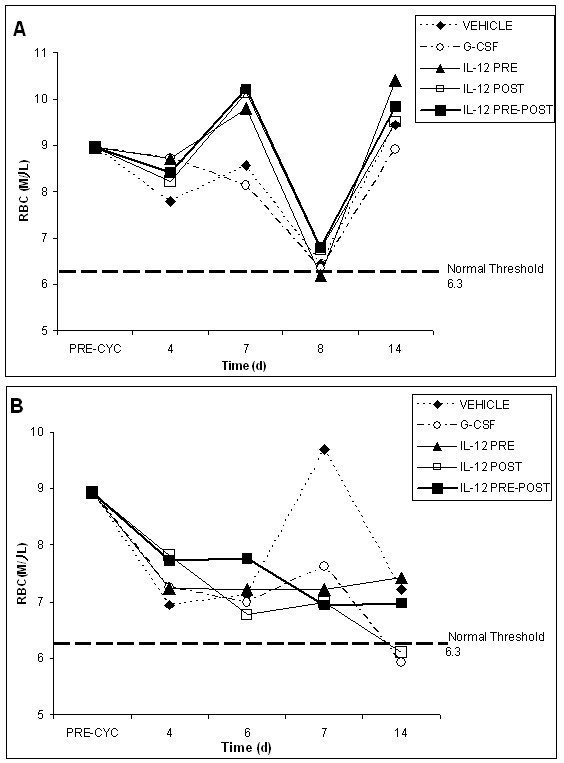
Red blood cell recovery profiles for vehicle, G-CSF, IL-12 pre-only, IL-12 post-only and IL-12 pre-post treatment groups following chemotherapy. Red blood cell recovery profiles are shown for the EL4 tumor model in (A) and the Lewis lung cancer model in (B). Pre-chemotherapy blood values reflect an average of all animals in both groups (80 mice) before cyclophosphamide and tumor inoculation. The normal threshold value for murine red blood cell counts is indicated. EL4 mice received a cyclophosphamide dose of 250 mg/kg and the LL mice received a cyclophosphamide dose of 225 mg/kg. IL-12 treated mice received a total dose of 50 ng (pre-only) and 150 ng (post-only and pre-post (pre-post dose was split 50 ng before and 100 ng after cyclophosphamide)), whereas G-CSF treated mice received a total dose 1.5 μg.